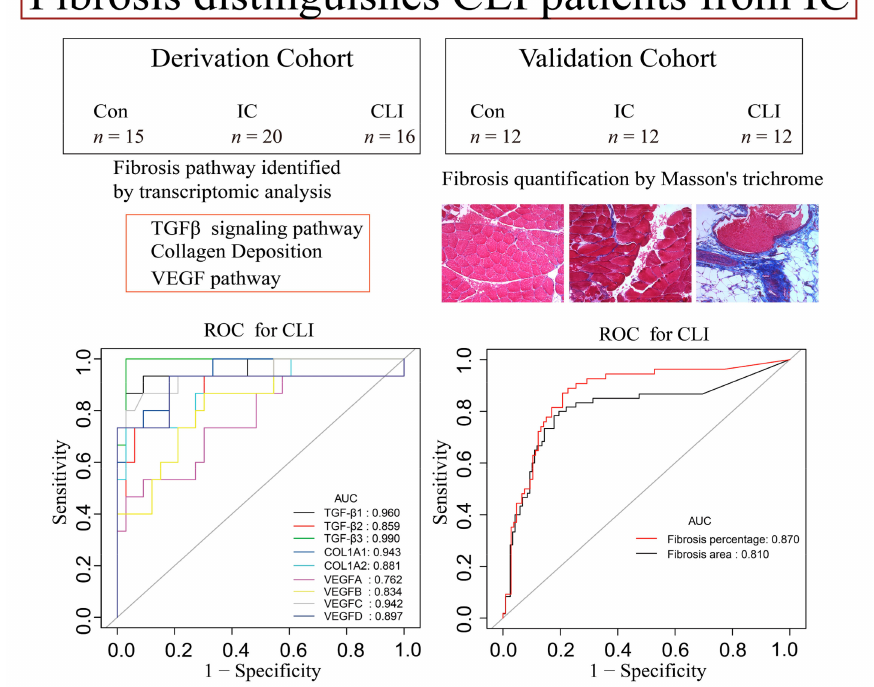
Figure 7. Derivation cohort included 15 non-PAD controls, 20 IC, and 16 CLI patients. Validation cohort included 12 non-PAD controls, 12 IC, and 12 CLI patients. Both fibrosis pathway identified by transcriptomics and fibrosis quantification by Masson trichrome of skeletal muscle demonstrated an area under the curve (AUC) over 0.75. This indicates that fibrosis distinguishes CLI patients from IC in a transcriptomic and histologic